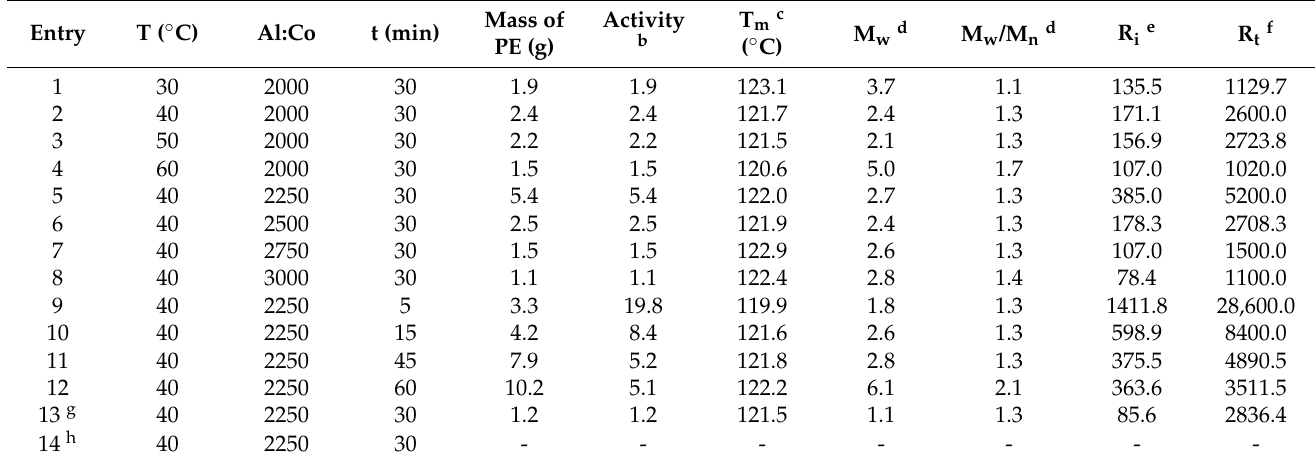
Table 4. Catalytic evaluation using Co6 /MMAO as the test system a